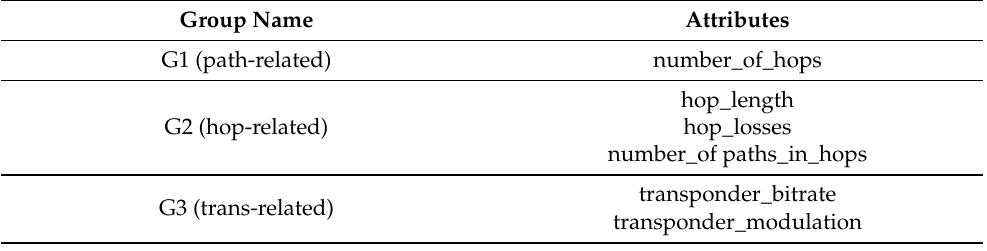
Table 1. Available attributes divided into three groups.